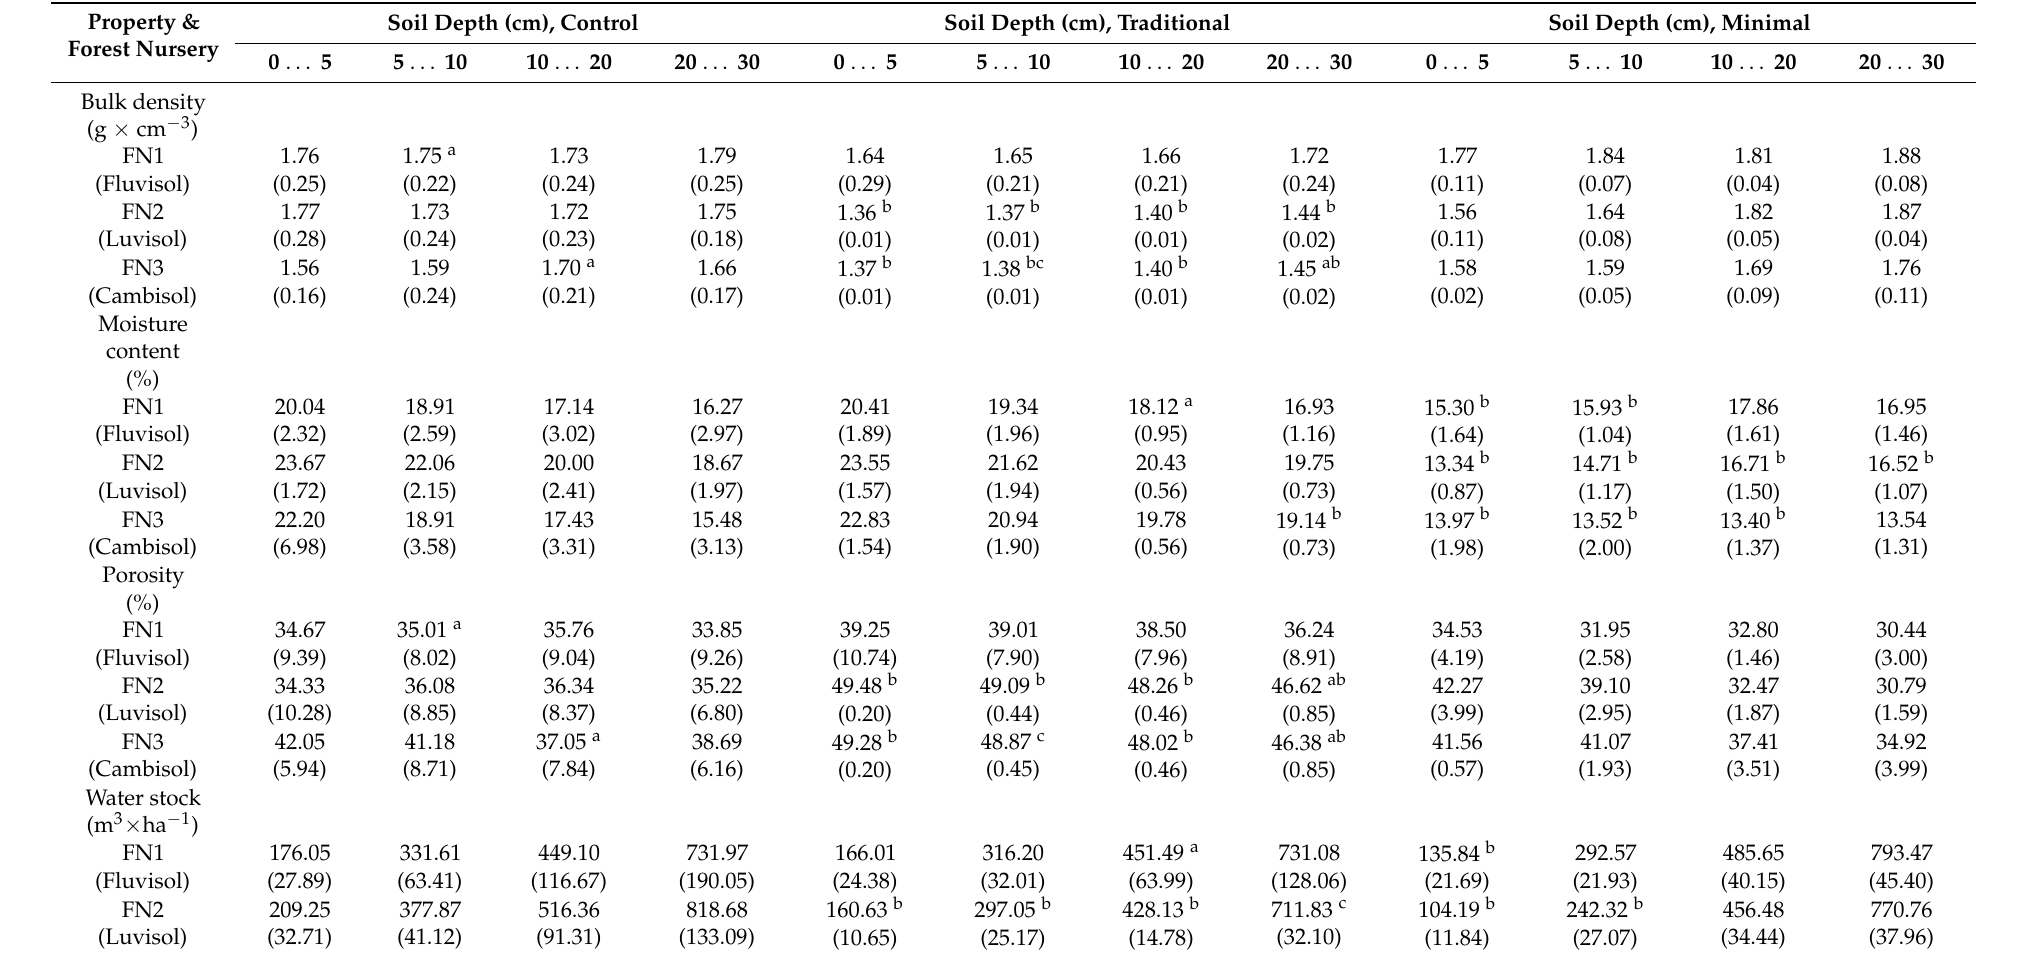
Table A3. Descriptive statistics and results of comparison tests on soils’ physical